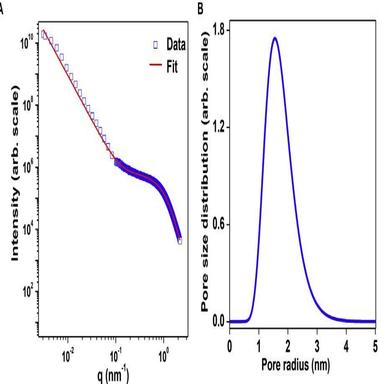
(A) Combined SAXS and MSANS profile of mesoporous alumina plotted on a double logarithmic scale. Line represents fitting of the model (equation) to the experimental data (B) Pore size distribution as obtained from fitting of the model to the experimental data.